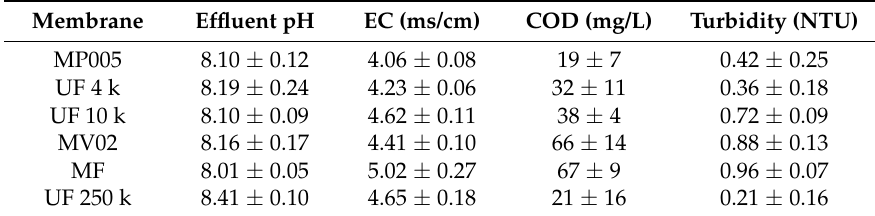
Table 3. Permeate analysis results after MBR operation.